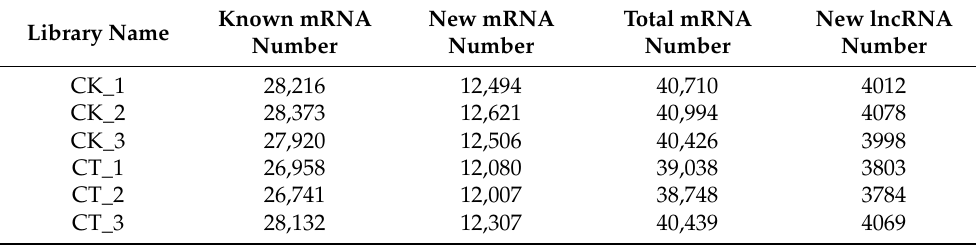
Table 2. Statistics of the lncRNAs identified from the six